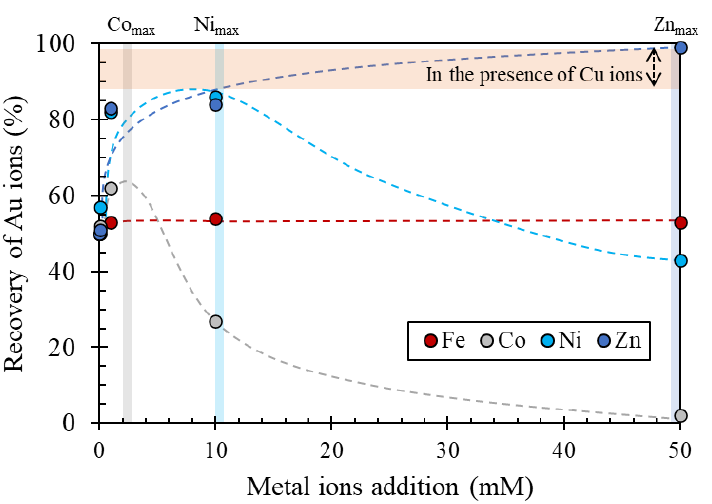
Figure 8. The competitive cementation tendency between Au ions and other base metal ions reacted on the surface of AC attached to ZVAl in the absence of Cu ions.